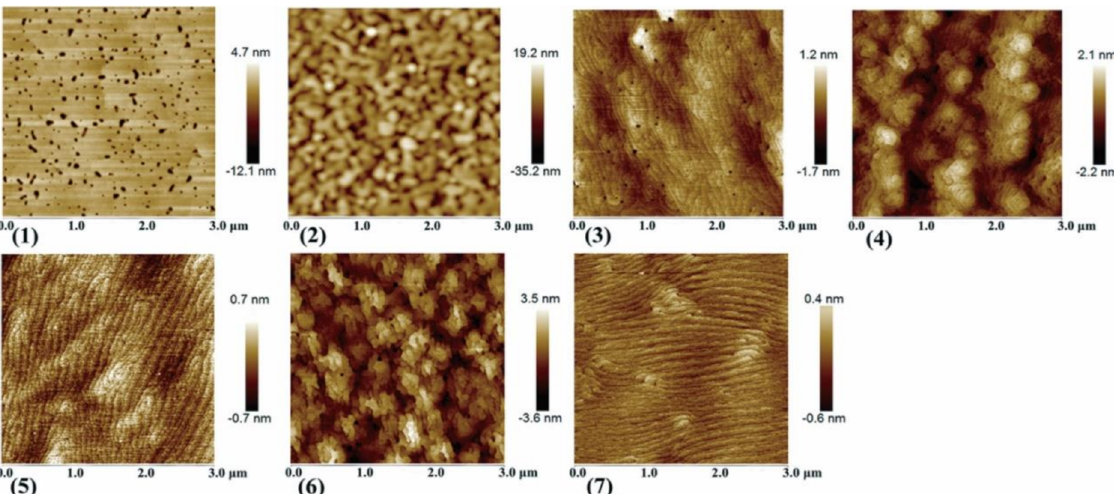
Figure 8. Plan-view AFM images (3 × 3 µ m 2 ) of MSG-AlN at different growth stages from ( 1 – 7 ). ( 1 ), ( 3 ), ( 5 ) and ( 7 ) correspond to the high temperature growth stages (1220 ◦ C) and ( 2 ), ( 4 ) and ( 6 ) correspond to the low temperature growth stages (1080 ◦ C). The surface morphology experienced multiple “rough-to-smooth” processes, and finally an atomically smooth surface was obtained. Reprinted from [44] with copyright permission.